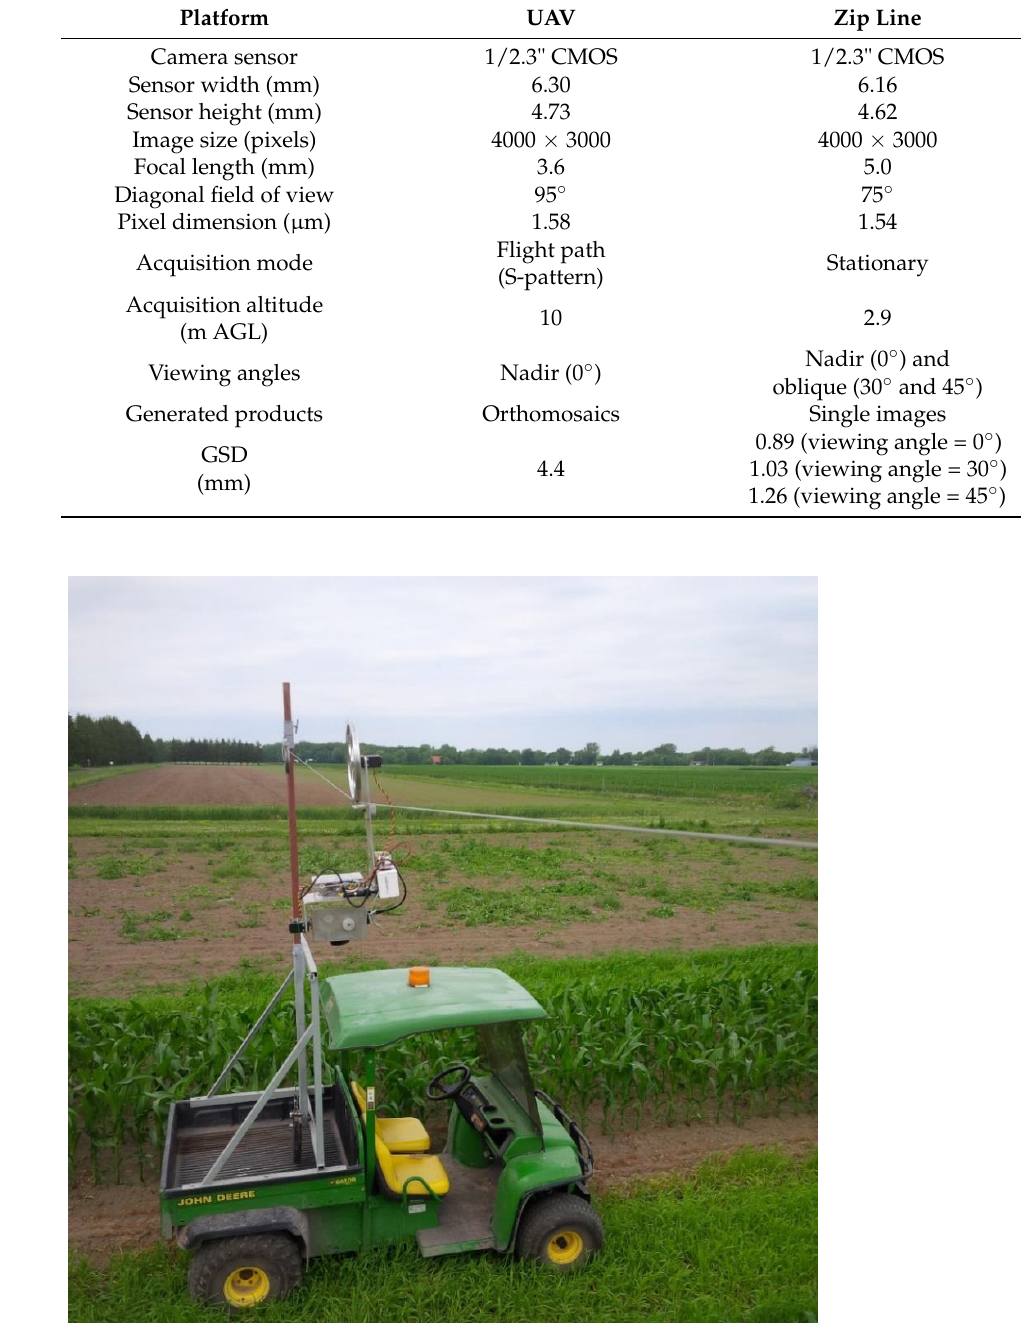
Table 1. Technical specifications of the cameras used for image acquisition.